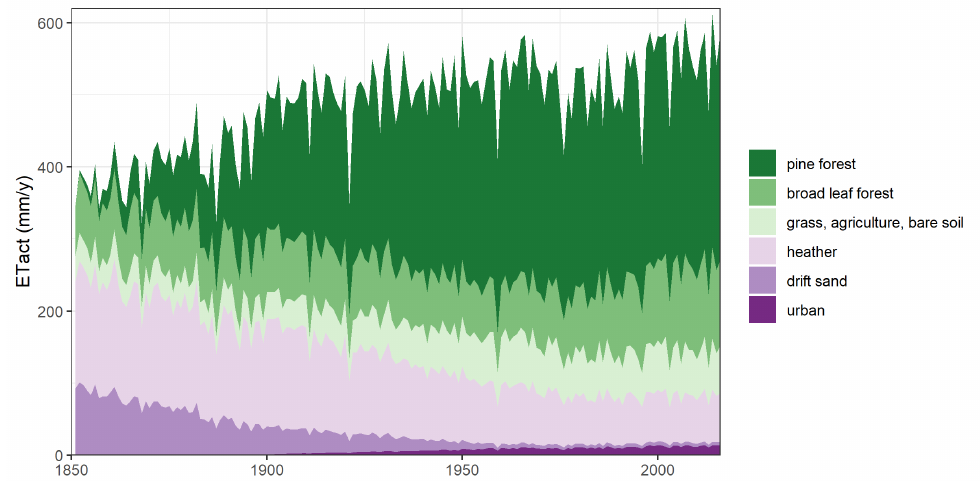
Figure 7. Mean yearly ET act for the entire Veluwe area with the contribution of every land use